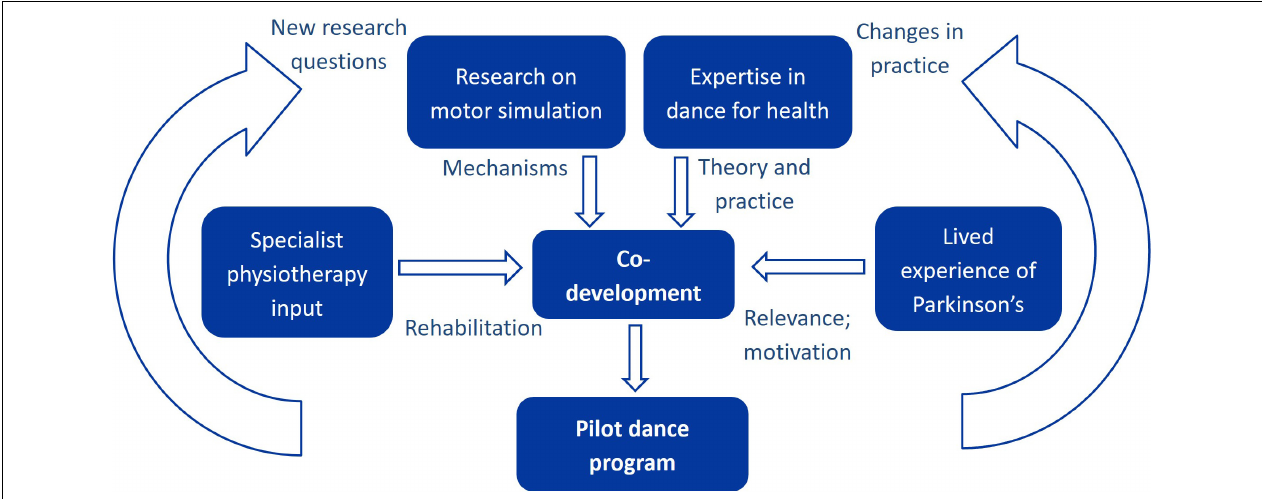
FIGURE 2 | Schematic indicating contributions of the different stakeholders to the co-development process, and the feedback of knowledge from the resulting dance program into both research and practice.